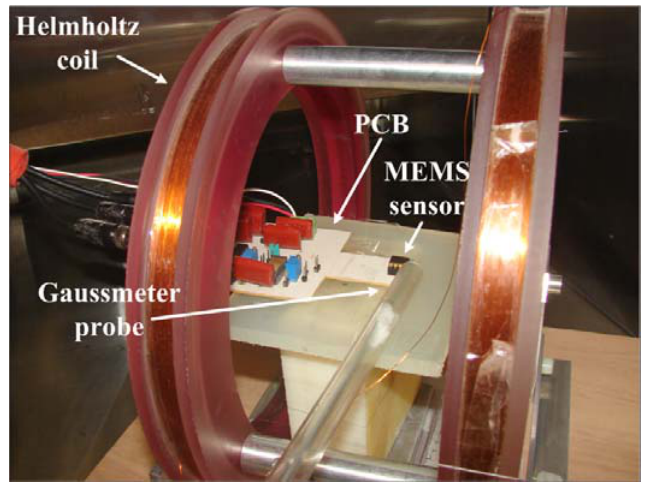
Figure 4. PCB of the MEMS sensor inside a Helmholtz